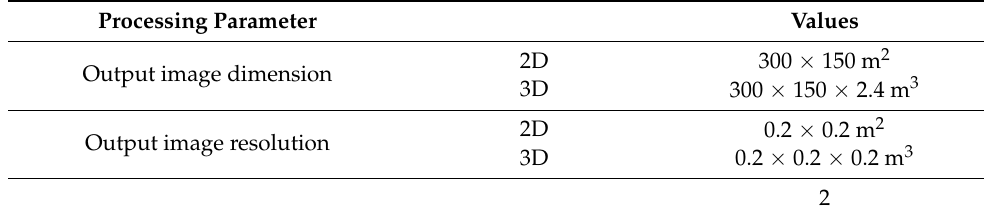
Table 3. Set of processing parameters for the case